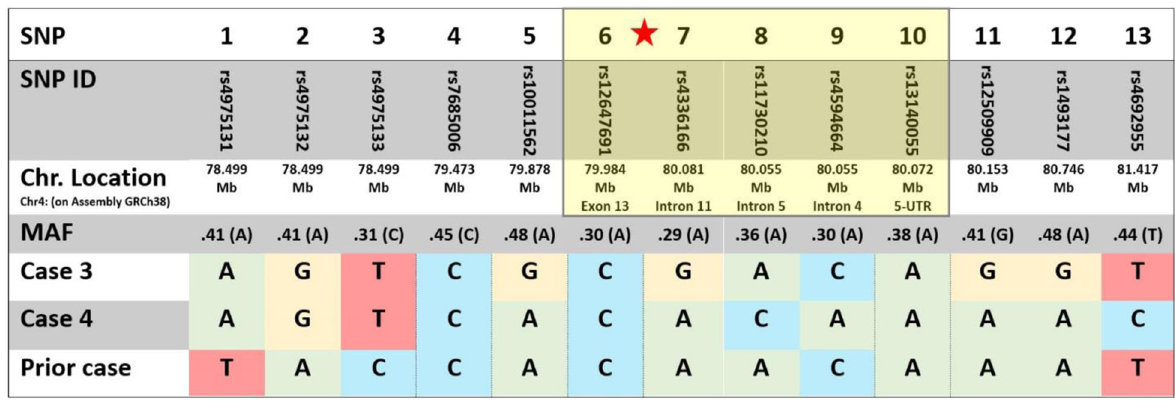
Haplotype analysis was performed in three cases of HFS homozygous for the c.1073dup (p.Ala359Cysfs*13) mutation in ANTXR2 , including Case 3 and Case 4 from the present report, and a previously reported patient of Iranian descent with the identical mutation. Thirteen informative single nucleotide polymorphisms (SNPs) with minor allele frequencies (MAF) ranging from 0.29 to 0.48 in a 2.91 Mb region of chromosome 4 (https://www.ncbi.nlm.nih.gov/SNP) were sequenced in each case, including five SNPs within the ANTXR2 gene (nos. 6-10, yellow highlight). The position of the c.1073dup mutation is indicated by a red asterisk. Analysis revealed that while each patient was homozygous for the allele of each included SNP as expected in consanguineous families, the SNP haplotype differed between these three cases. These data suggest an independent origin of this mutation event rather than being inherited from a common